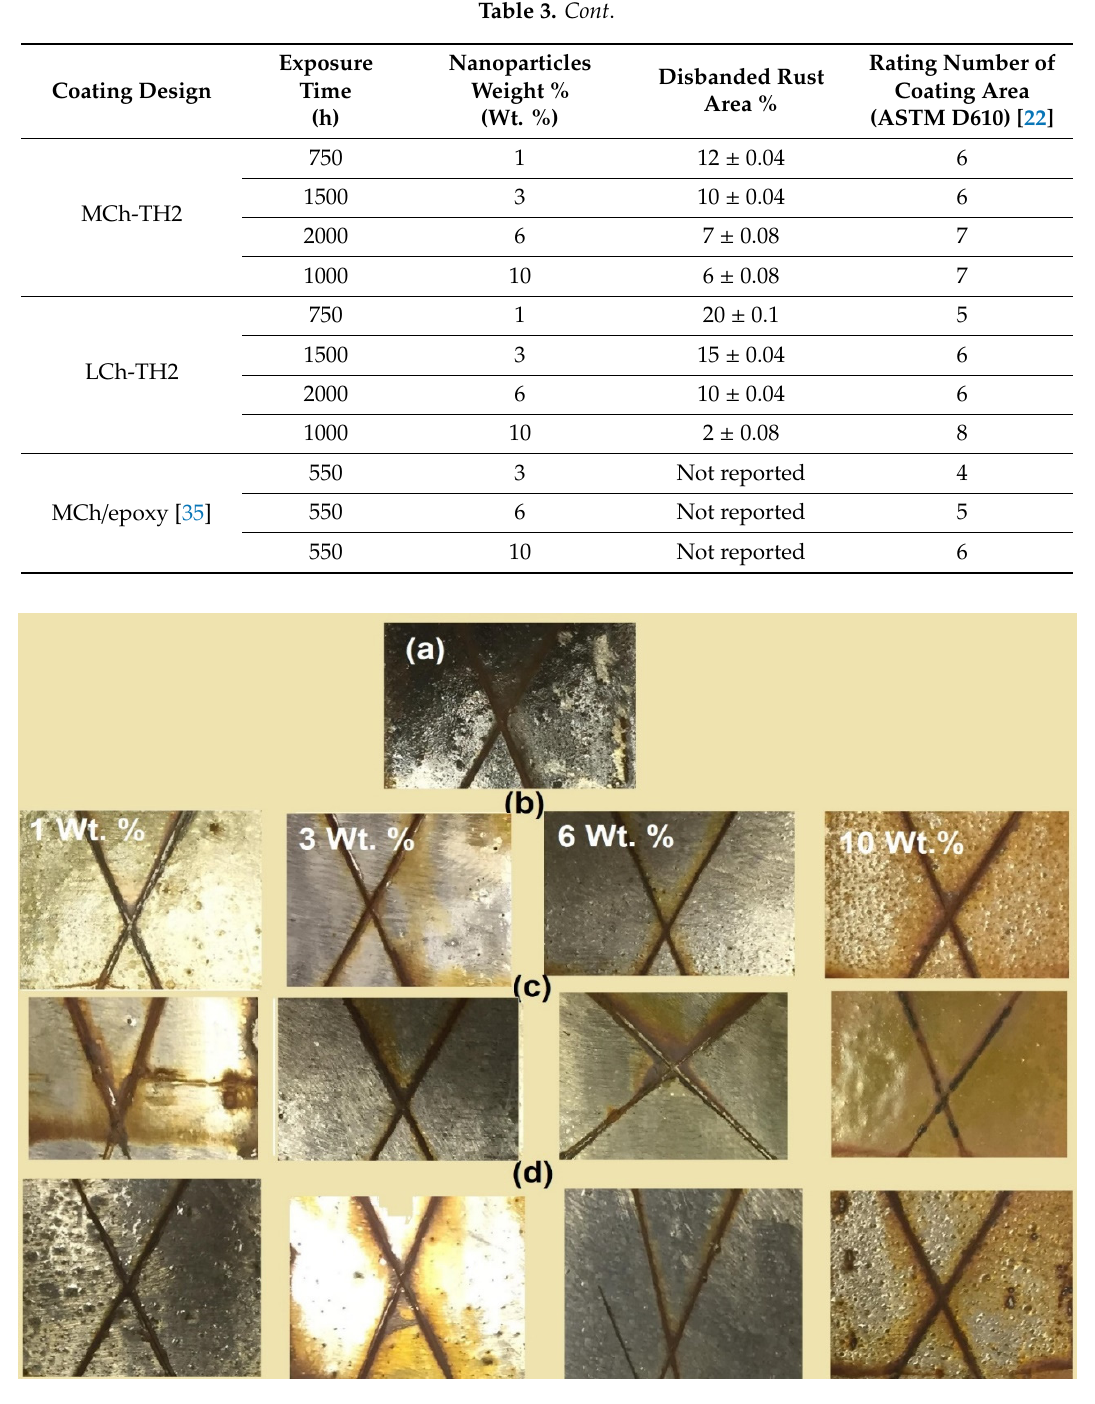
Figure 8. Salt spray resistance photos of epoxy coating mixed with different Wt. % of ( a ) 0, ( b ) HCh-TH2, ( c ) MCh-TH2, and ( d ) LCh-TH2 at different exposure times.